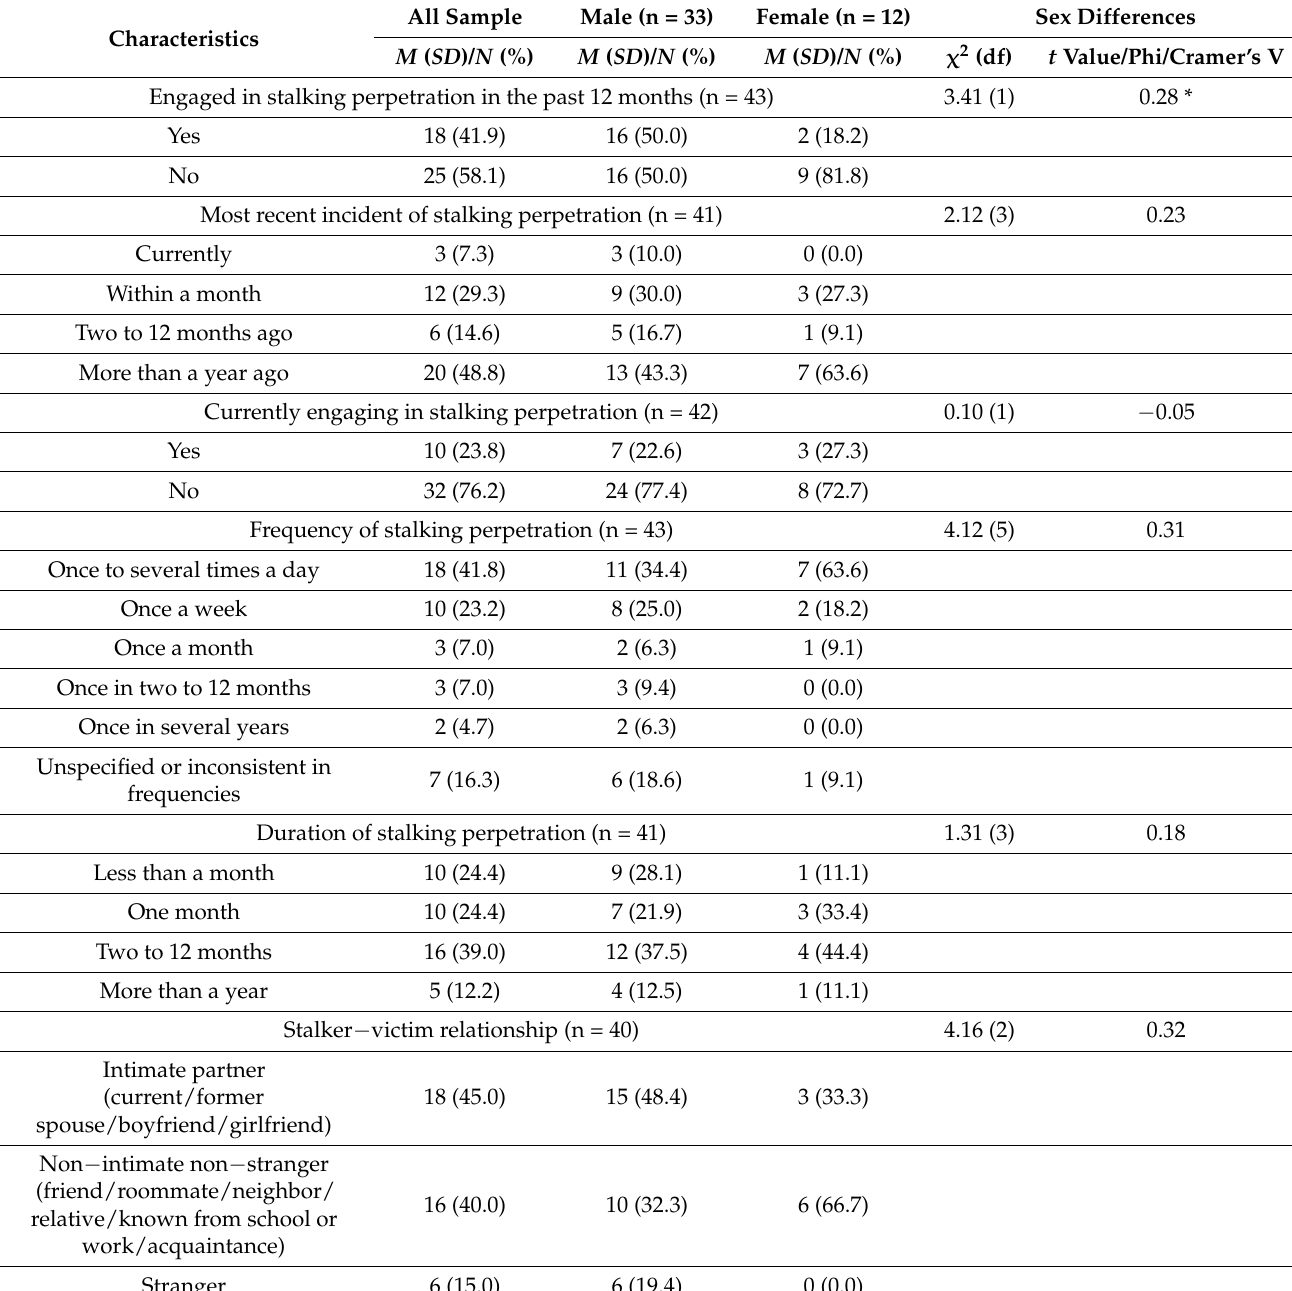
Table 1. Offending characteristics of the most recent (past 12 months) stalking perpetration by young adults in Hong Kong ( N =